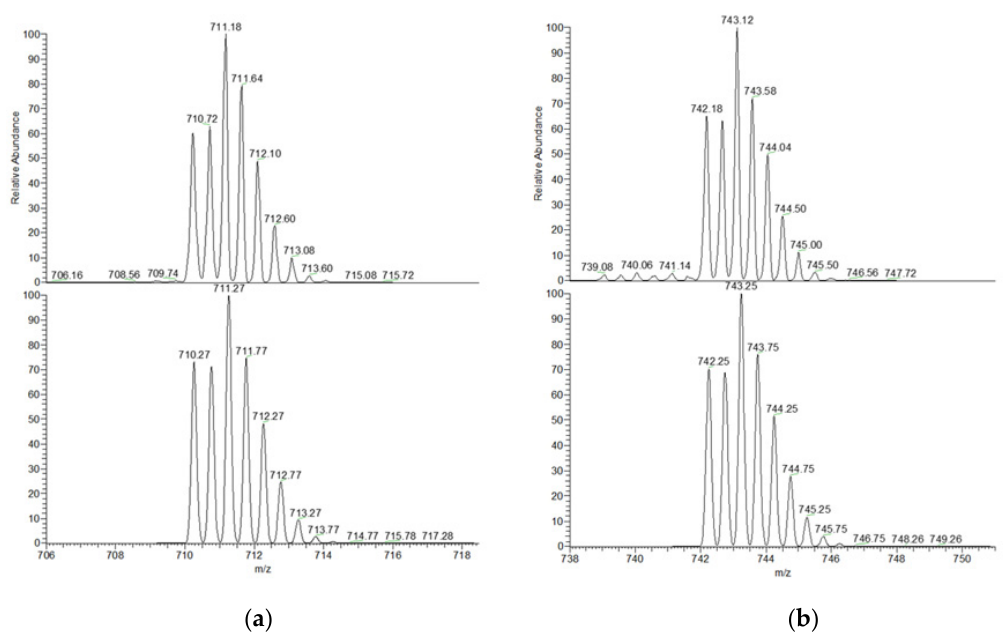
Figure 7. Top: zoom scans of the peaks at 711 m / z and 743 m / z, obtained from the experimental mass spectrum of an equimolar solution of [Cu 2 L] 4+ and either dfc 2 − ( a ) or sdbz 2 − ( b ) in CH 3 CN:H 2 O 4:1. Bottom: simulated peaks, calculated for the double charged adduct [Cu 2 C 86 H 86 N 8 O 4 ] 2+ ( a ) and [Cu 2 C 86 H 86 N 8 O 6 S] 2+ ( b ).